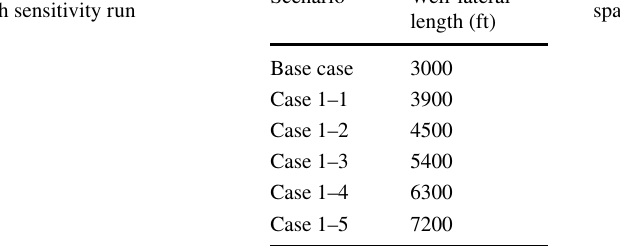
Table 9 Scenarios for fracture-